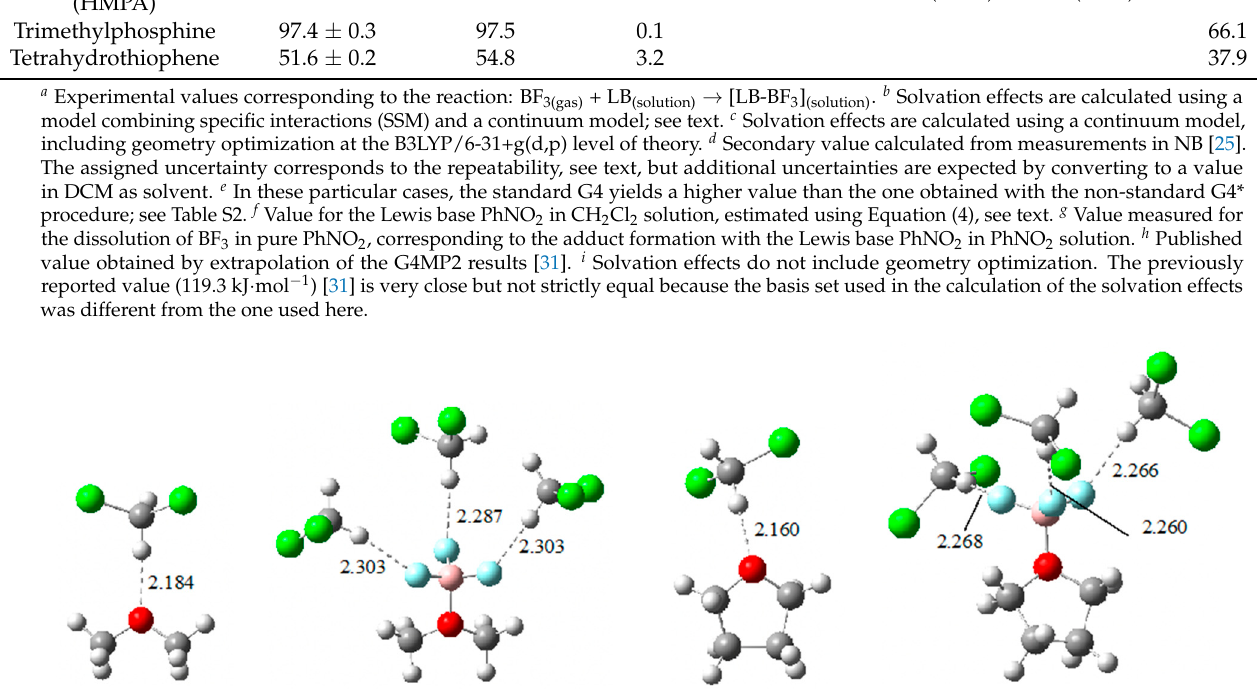
Figure 2. Examples of B3LYP/6.31+G(d,p) optimized structures of hydrogen bonded species which were considered for the specific solvation effect by DCM for dimethyl ether and tetrahydrofuran as suitable example. Before adduct formation, the Lewis base is in interaction with one DCM molecule. Meanwhile, the BF 3 adduct is in interaction with three DCM molecules through the three fluorine atoms. H-Bond distances in Å.